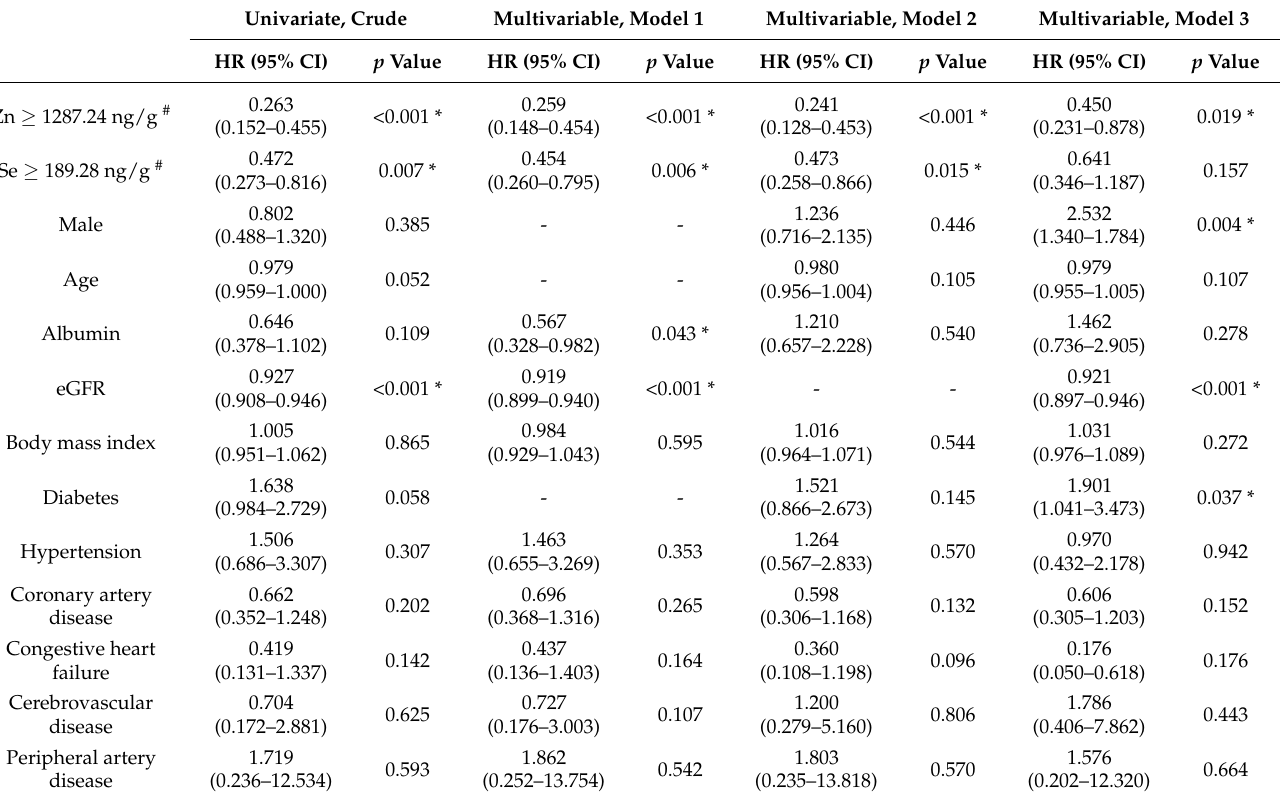
Table 5. Cox regression analysis on the association of factors and ESRD needing dialysis. Univariate, Crude Multivariable, Model 1 Multivariable, Model 2 Multivariable, Model